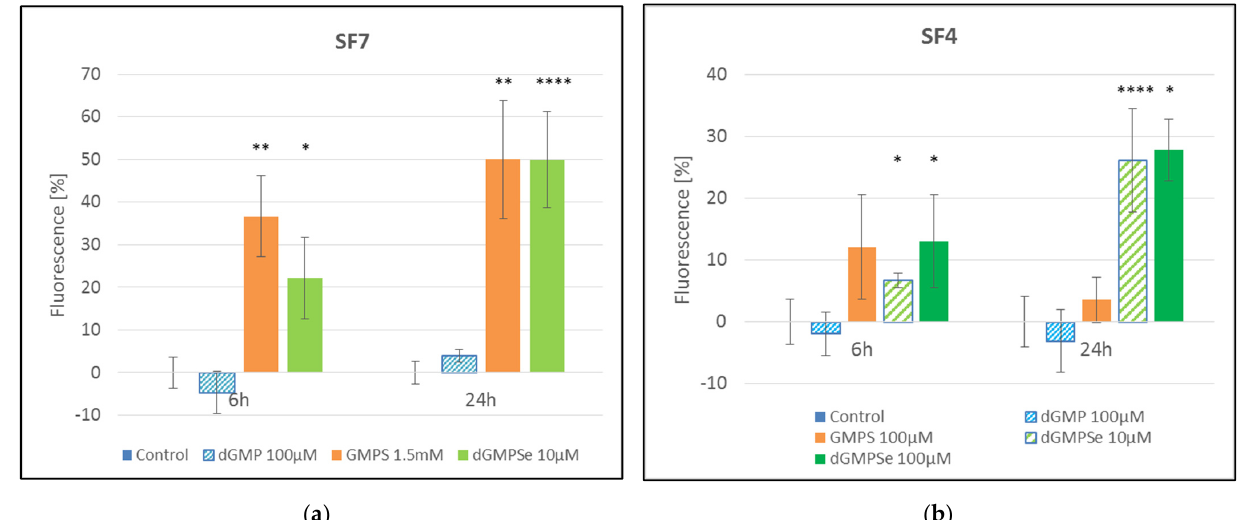
Figure 9. Quantification of fluorescence corresponding to H 2 Se or H 2 S release using 2.5 µM SF7 ( a ) and 5 µM SF4 ( b ) probes in live HeLa cells after electroporation of dGMPSe or GMPS (positive control). H 2 O electroporated cells were used as control. Data were collected after 6 or 24 h at 10